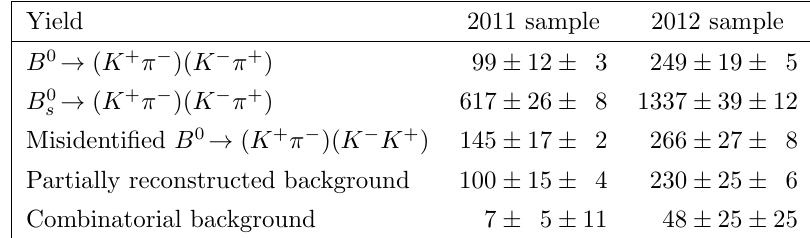
Table 3 . Signal and background yields for the 2011 and 2012 data samples, obtained from the (cid:12)t to the four-body mass spectrum of the selected candidates. Statistical and systematic uncertainties are reported, the latter are estimated as explained in section